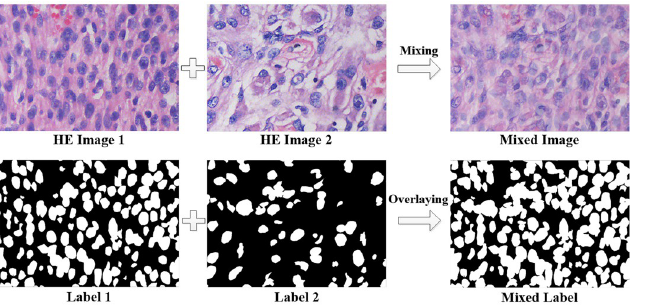
Fig 4. Full mixup operation diagram. The first line is the mixing process of HE images, and the second line is the mixing process of labels.